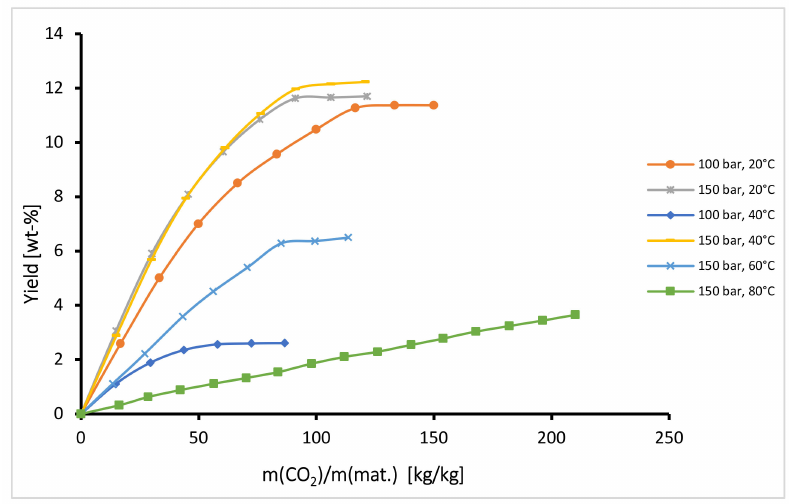
Figure 1. Kinetics of semi-continuous extraction of hops with dense CO 2